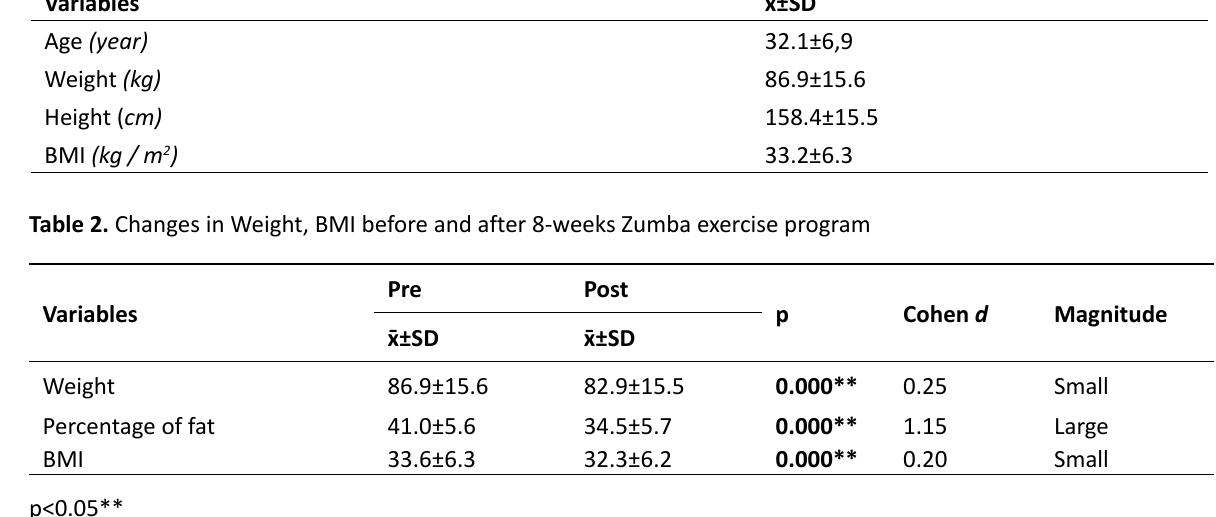
Table 1. Physiological characteristics of participants